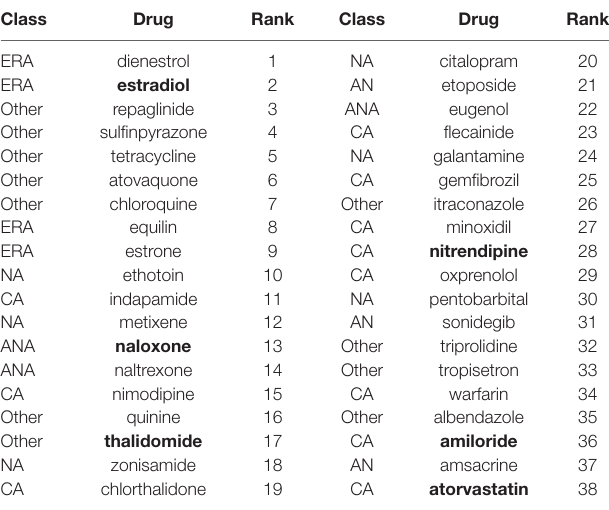
TABLE 1 | Preliminary candidate drugs for DCM. TABLE 2 | Preliminary candidate drugs for ISCM.